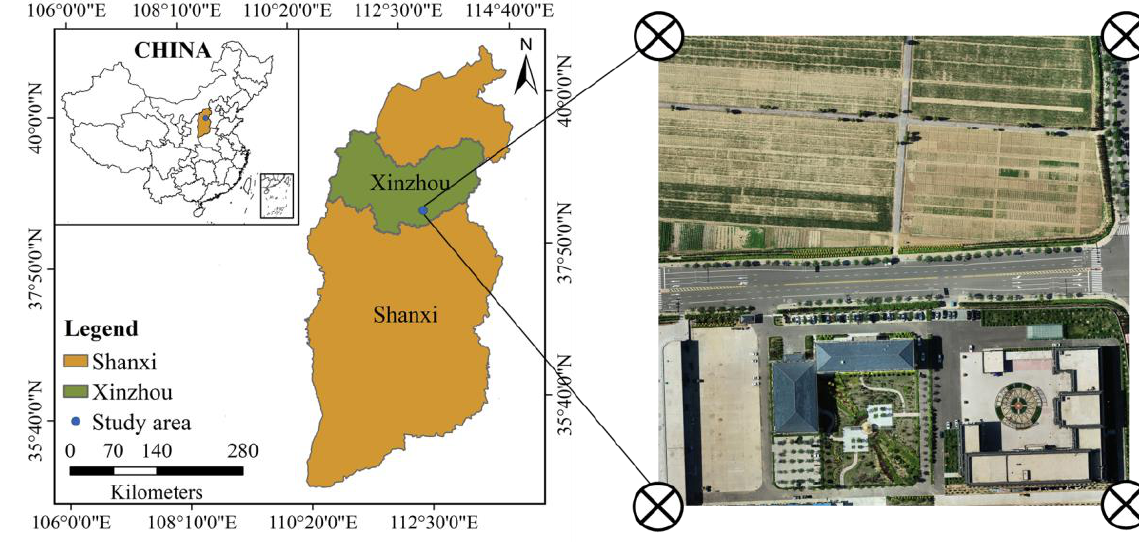
Figure 5. Geographical position of study area.